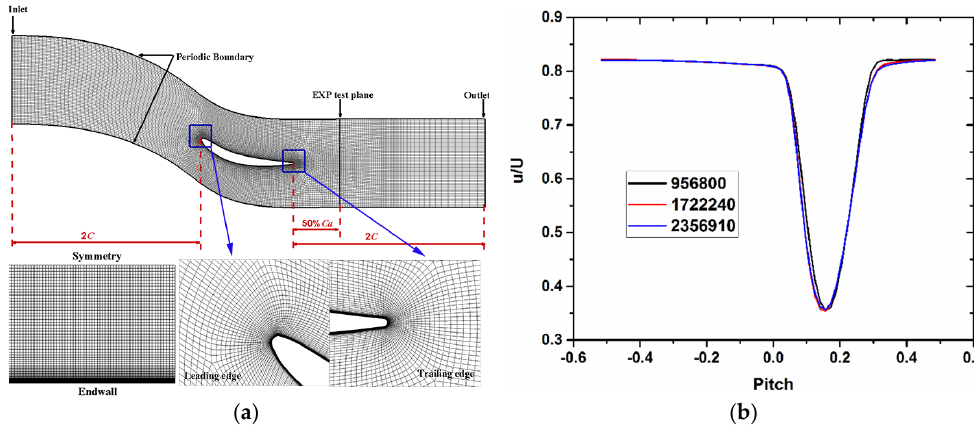
Figure 2. Grid independence test: ( a ) view of the computation domain and RANS mesh; and ( b ) velocity distribution at 10% of the span at the trailing edge.